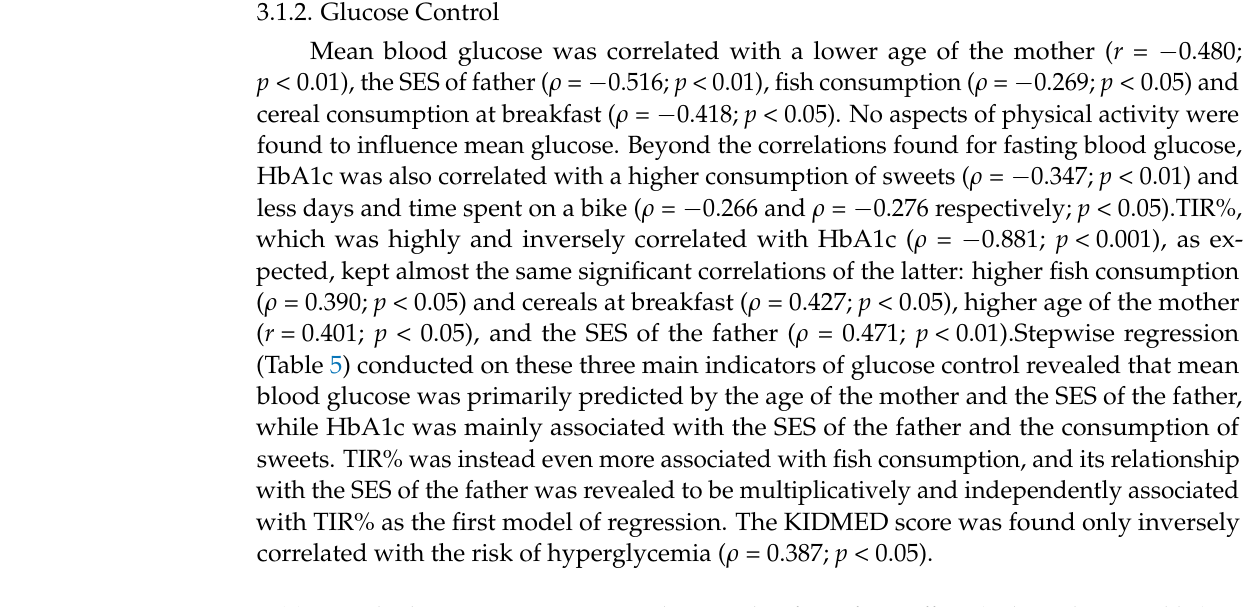
Table 5. Multiple stepwise regression analysis results of significant effects (independent variables) on glucose control main parameters (dependent